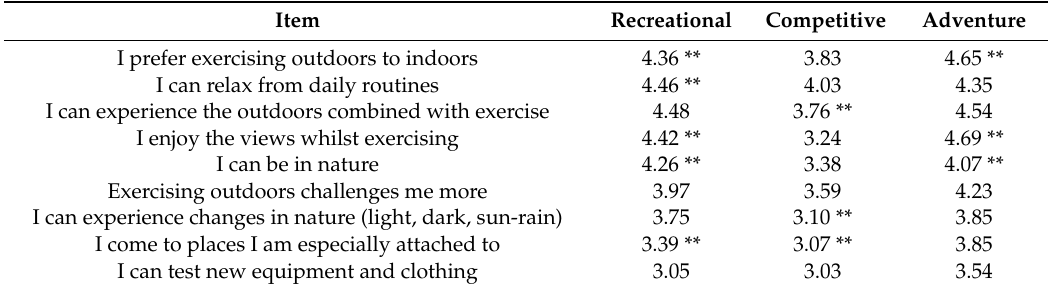
Table 4. Nature questionnaire for di ff erent outdoor activities.